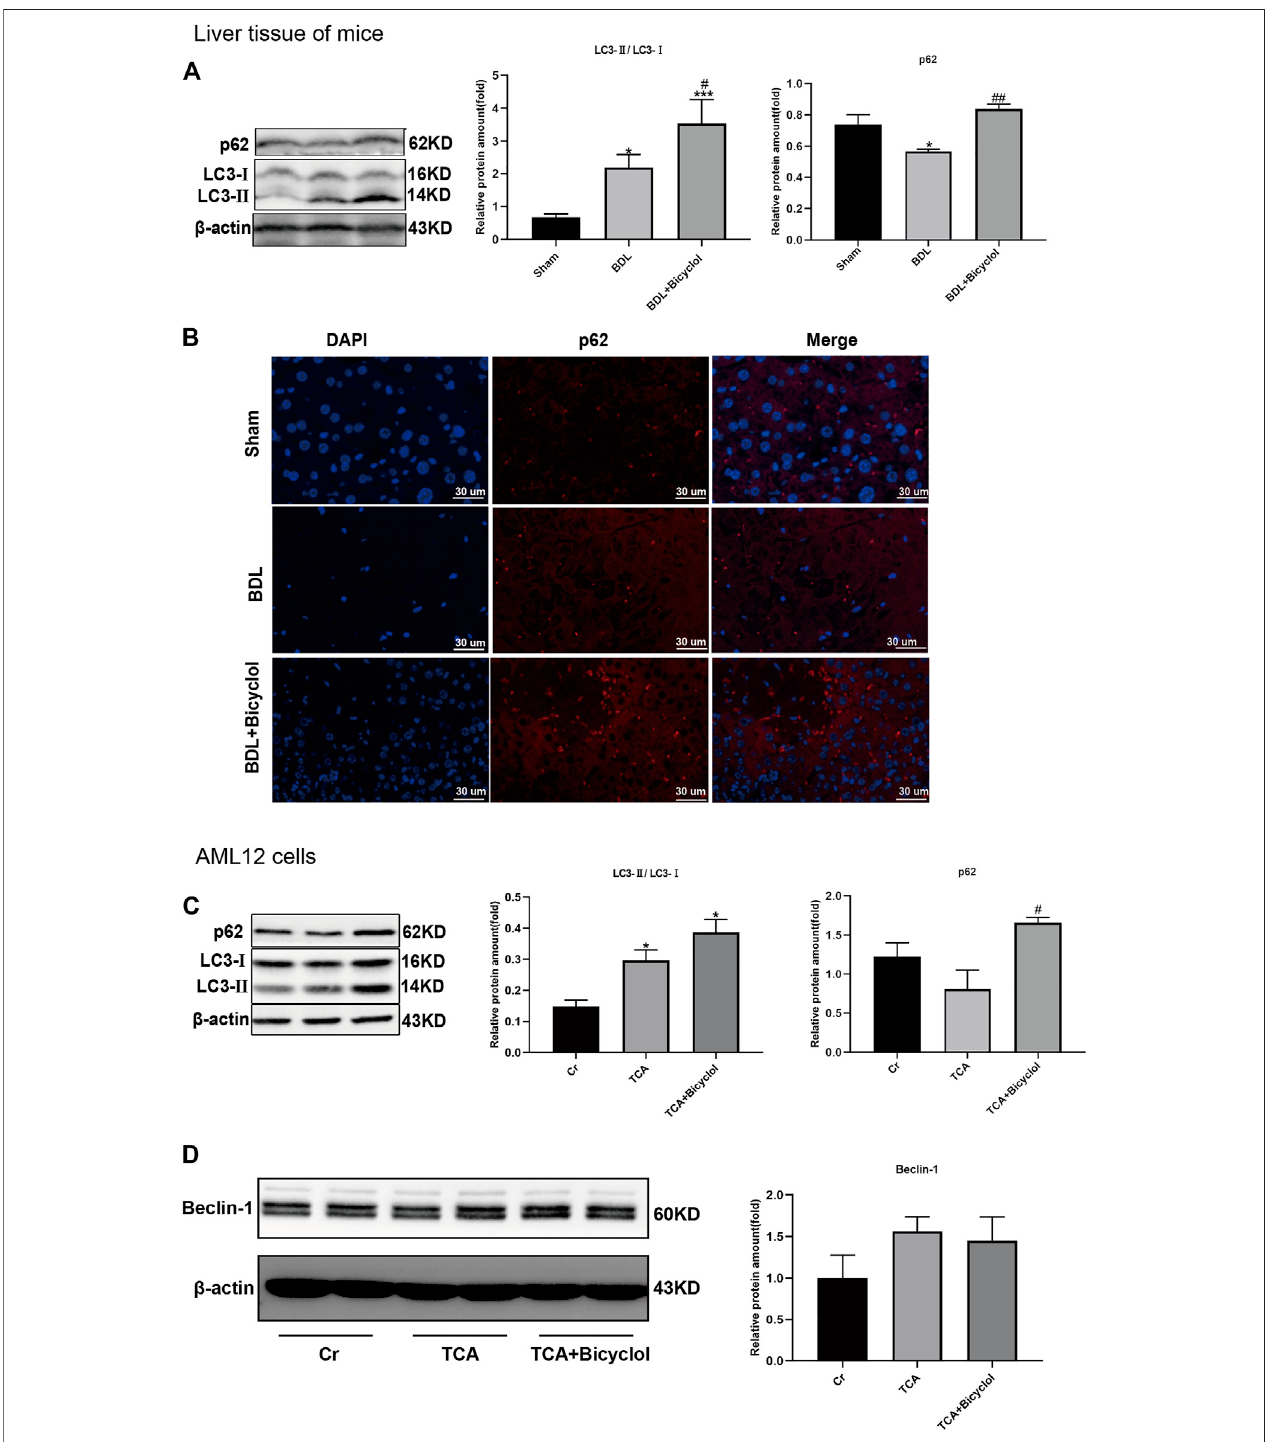
FIGURE5| Effectofbicyclolonautophagy. (A) P62andLC3- Ⅱ proteinlevelsinmiceweredetectedbywesternblot. (B) Paraf fi nsectionsoflivertissuewerestained withp62(red) andcounterstainedwithDAPItovisualizenuclei(blue)byimmuno fl uorescence.Scalebar,30 um. (C) Immunoblotsforp62andLC3- Ⅱ inAML12cells. (D) ImmunoblotsforBeclin-1inAML12cells.* p < 0.05vs.shamorCr; # p < 0.05, ## p < 0.01, ### p < 0.001vs.BDLorTCA.Proteinlevelswerenormalizedtolevelsof β -actin.